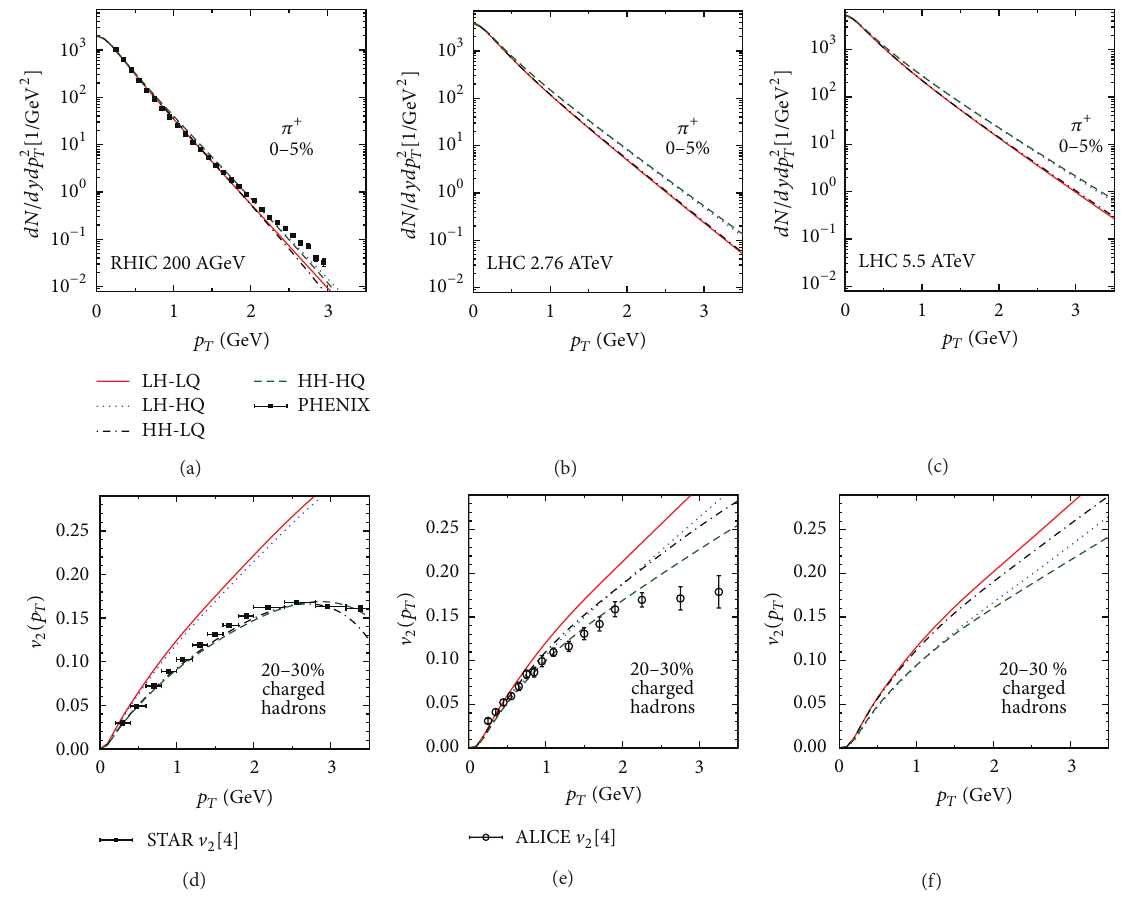
Figure 11: Transverse momentum spectra of positive pions in the 0–5% most central collisions and elliptic flow coefficients in the 20– 30% centrality class at RHIC and LHC. Different curves correspond to the different parametrizations of the temperature dependence of 𝜂/𝑠 described in the text. For details, see